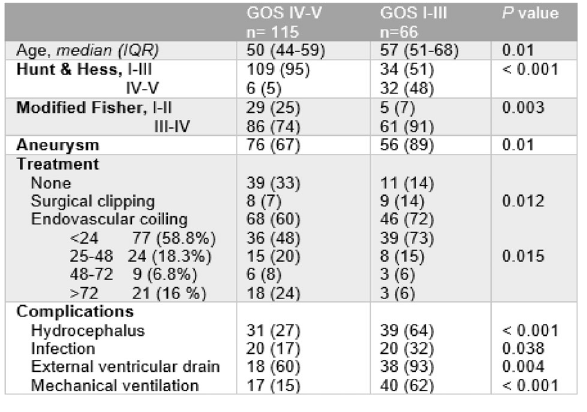
Table 1 (abstract 001371). See text for description